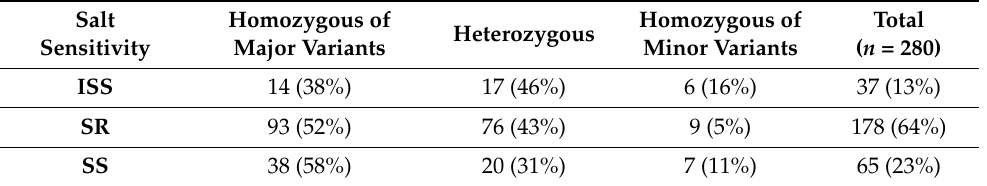
Table 1. Distribution of α ENaC rare variant, rs4764586, in different salt sensitivities. Homozygous of Total Salt Homozygous of Heterozygous Minor Variants ( n = 280) Sensitivity Major Variants ISS 14 (38%) 17 (46%) 6 (16%) 37 (13%) SR 93 (52%) 76 (43%) 9